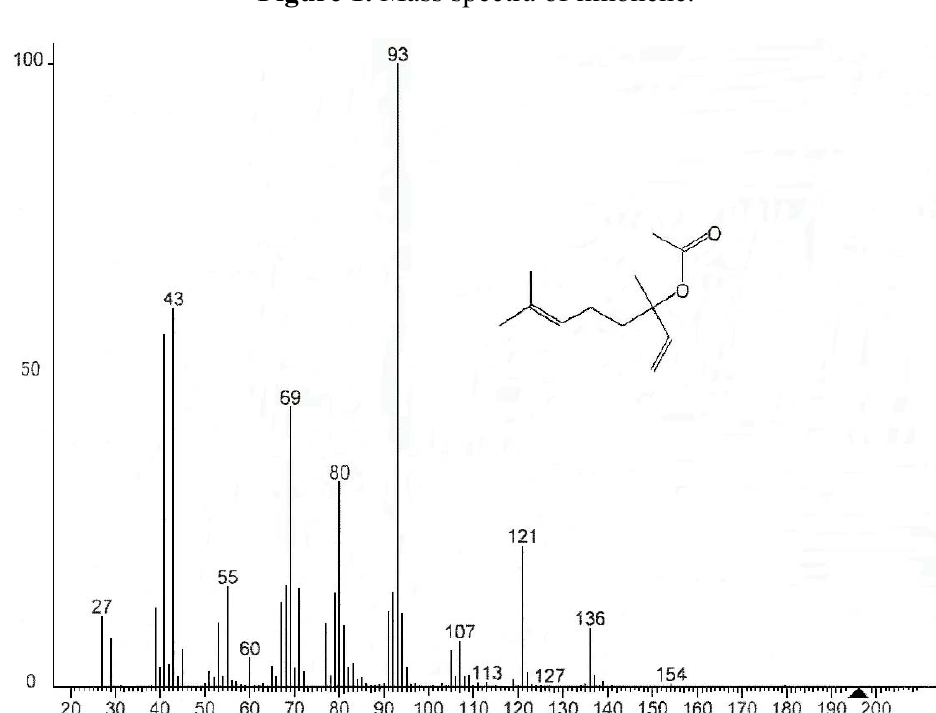
Figure 2. Mass spectra of linalyl